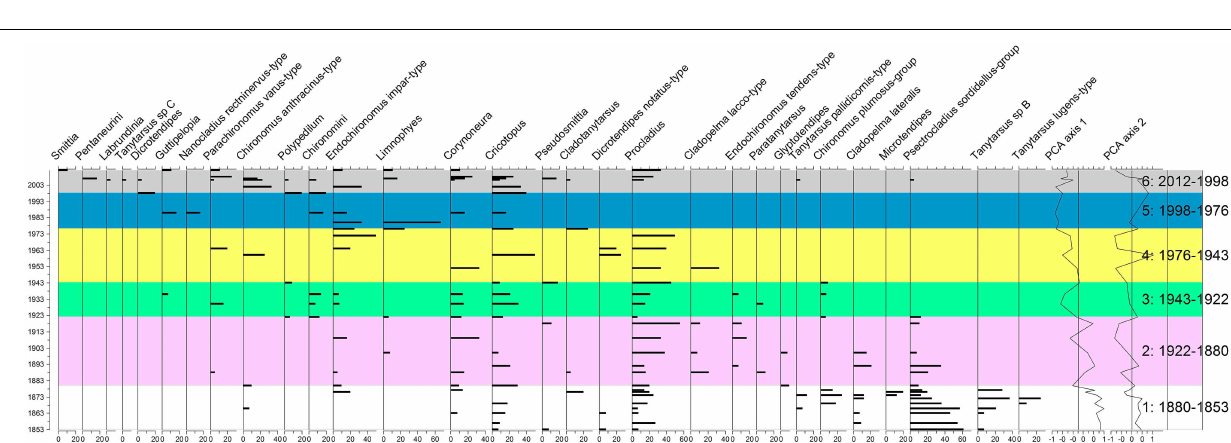
Aulacoseira ambigua, and Achnanthidium minutissimum